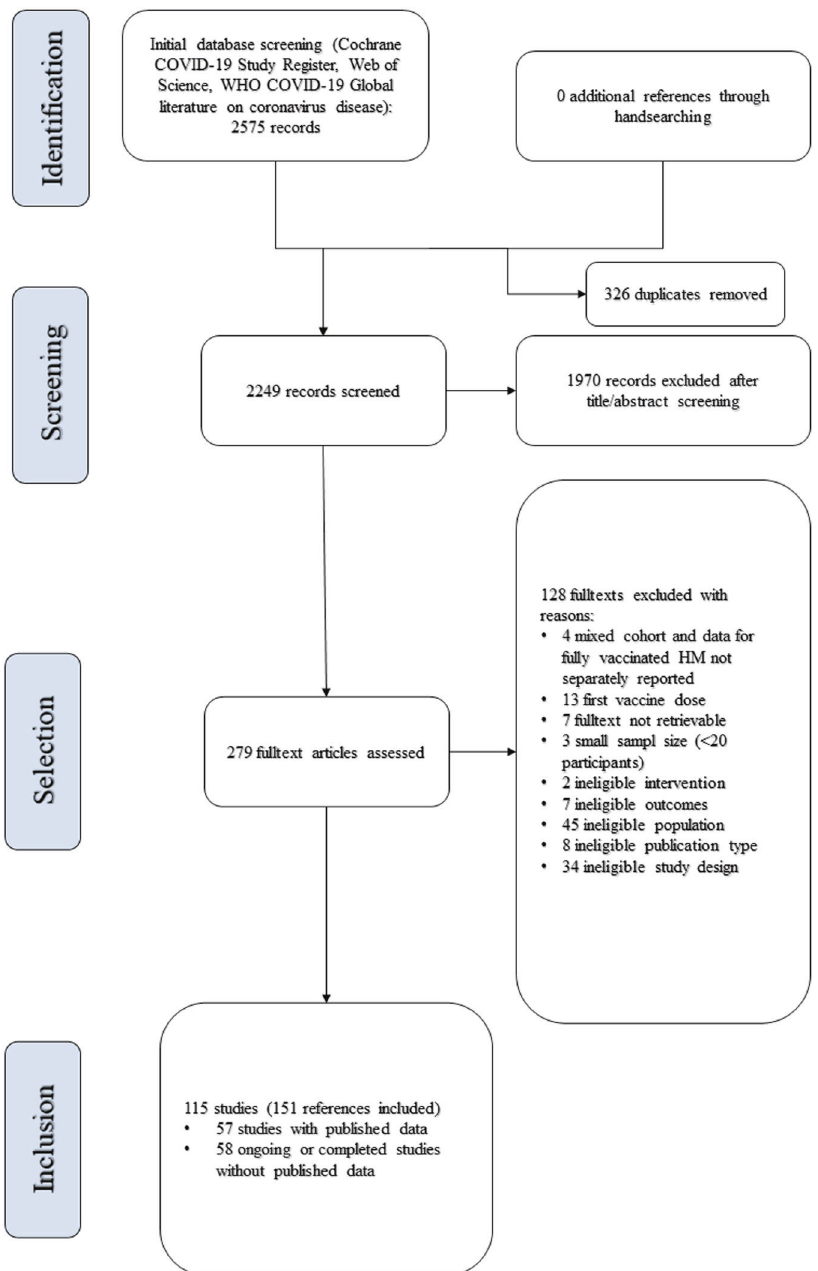
Fig. 1 PRISMA fl ow diagram. Selection process for articles included in systematic